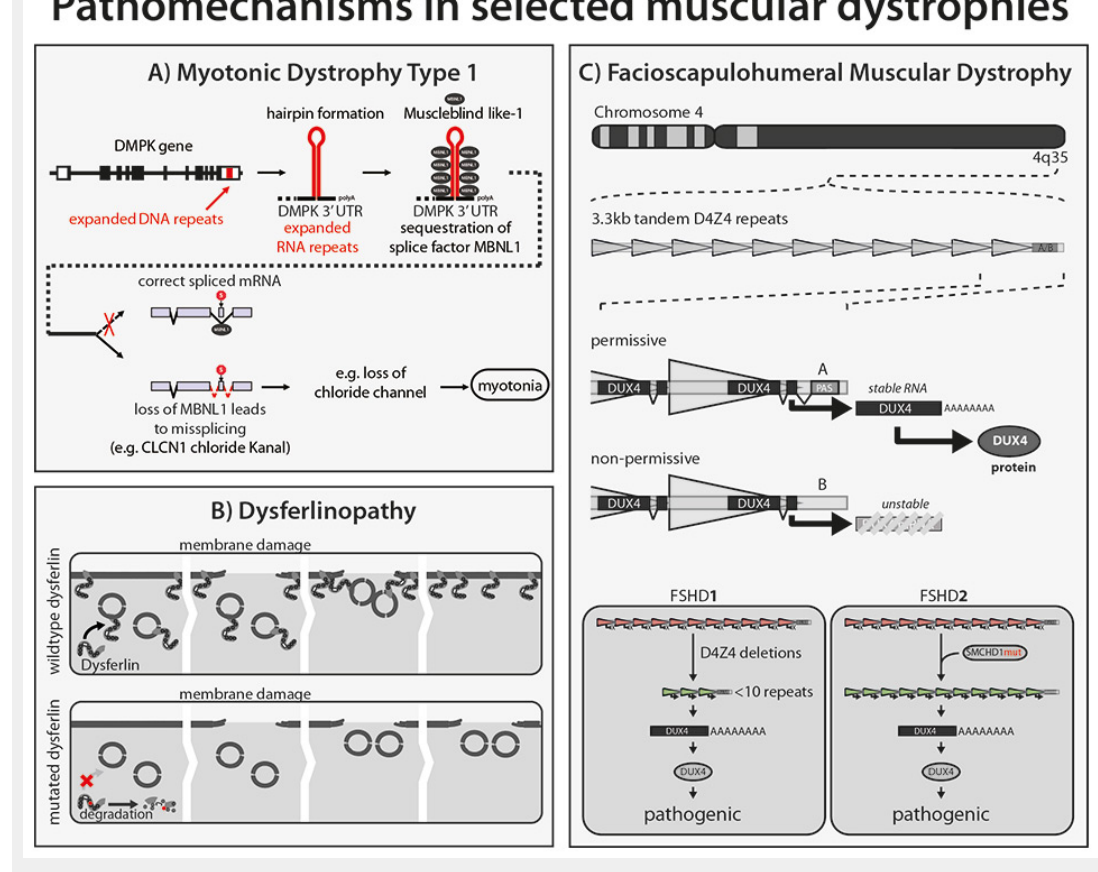
Figure 4 Molecular pathomechanisms in muscular dystrophies. Illustration of the molecular pathomechanisms of myotonic dystrophy type 1 (A), dysferlionpathy (B), and facioscapulohumeral muscular dystrophy (C). (A) Missplicing in myotonic dystrophy type 1 (DM1). The molecular basis of DM1 is an expansion of an unstable repeat sequence in the noncoding part of the DMPK gene. Severity of disease is correlated with repeat expansion size. In DM1 the mutation is located in a noncoding region and does not alter the protein sequence, but leads to toxic RNA. The sequestration of the alternative splicing factor MBNL1 by toxic RNA leads to altered splicing of target mRNAs like the muscle-specific CLCN1 chloride channel. The missplicing of the chloride channel leads to a loss of protein and finally to symptoms of myotonia. (B) Defective membrane repair in dysferlinopathy. Normal muscle cells respond to membrane damage by the recruitment of vesicles. In a dysferlin dependent mechanism the vesicle fuse to form a membrane patch sealing the damaged membrane. In dysferlinopathy patients, mutations in the dysferlin gene leading to a loss of dysferlin and the muscle cells are not capable to repair the membrane. (C) Toxic expression of DUX4 in facioscapulohumeral muscular dystrophy (FSHD). The FSHD locus maps to chromosome 4q35 and consists of a variable number of tandem repeats (D4Z4), which in normal individuals usually consist in multiple copies (>11). In FSHD patients, DUX4 protein is expressed upon epigenetic activation of the locus and stabilisation of the DUX4 mRNA by a polyadenylation site (PAS). The activation of DUX4 transcription is a consequence of a D4Z4 repeat deletion (<11 repeats) or of a mutation in the SMCHD1 gene. The expression of the DUX4 protein, normally not present in muscle cells, leads to activation of a set of genes inducing muscle cell